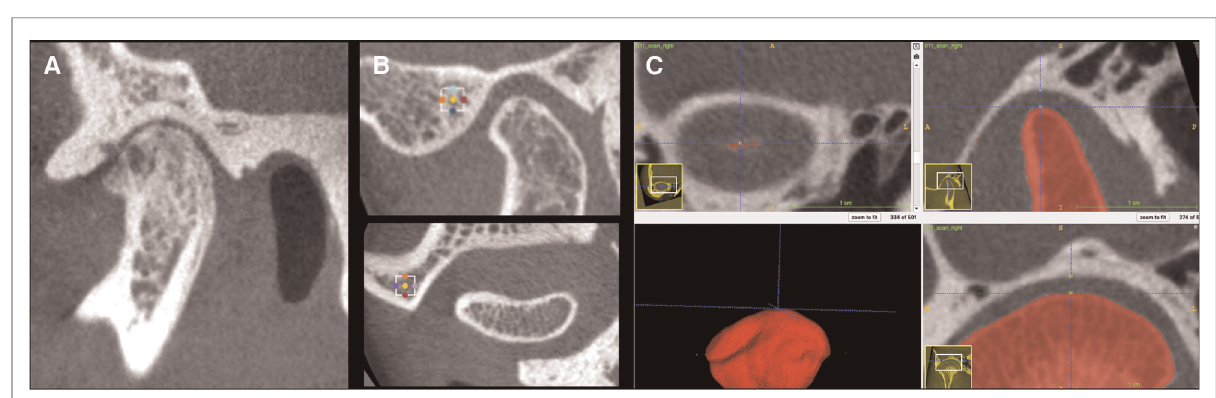
FIGURE 2 TMJ imaging protocol. ( A ) Small FOV hr-CBCT scans for TMJ imaging features analysis. Note that marked bone destruction is seen in the condyle and the articular fossa also shows erosion. ( B ) Volumes of interest (VOIs) in the lateral portion of the articular fossa and in the articular eminence regions. ( C ) Superior condylar-to-fossa distance as indicated by the blue axis line seen in the coronal and sagittal